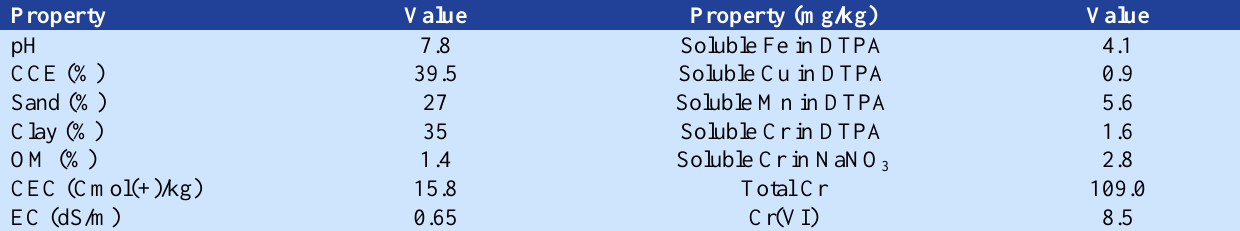
Table 1. Selected chemical and physical properties of studied soil